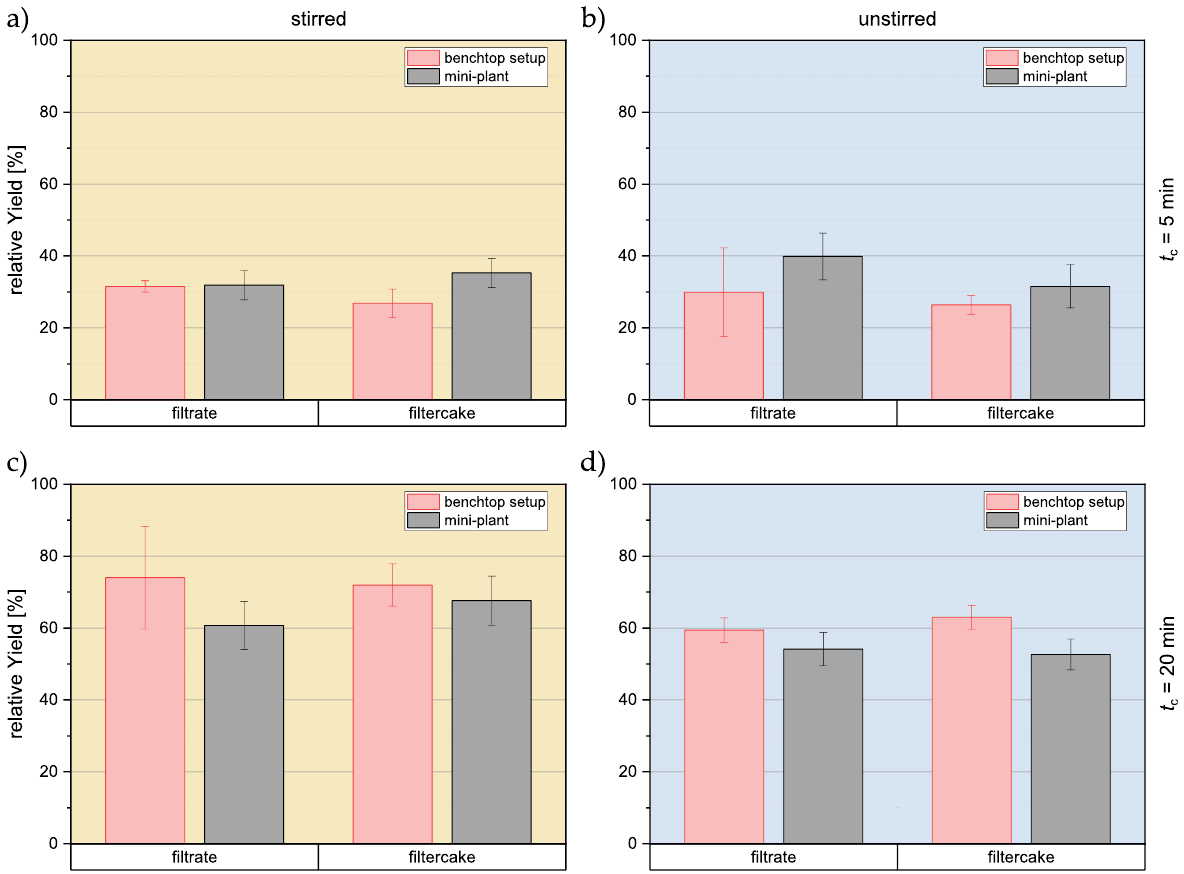
Figure 7. Representation of the yield achieved from the different experimental settings and two evaluation methods: stirred and t c = 5min in ( a ); unstirred and t c = 5min in ( b ); stirred and t c = 20min in ( c ); unstirred and t c = 20min in ( d ). Each of the experiments was performed in a fourfold manner. The standard deviations are